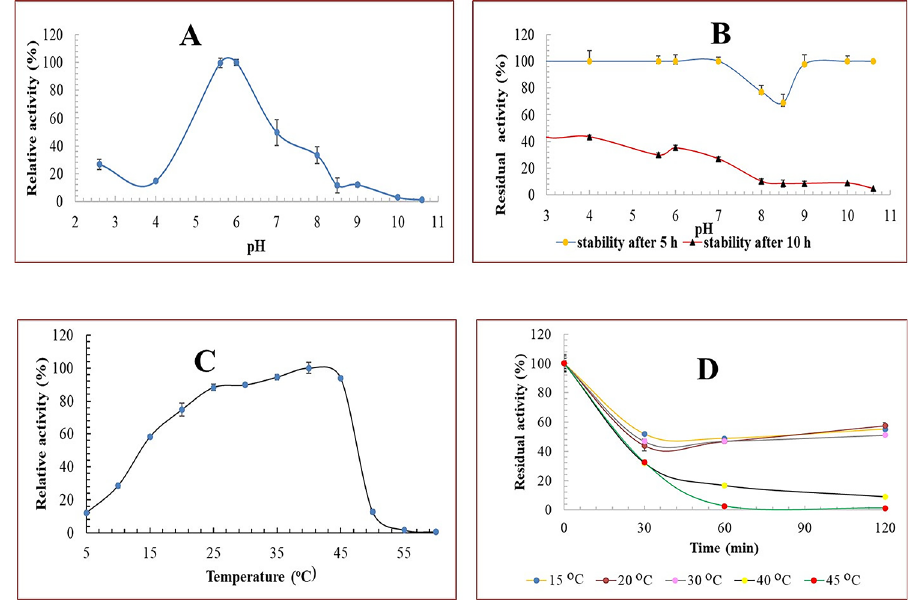
Fig. 2 pH-temperature profile of purified to homogeneity Pull_Met. A) Pull_Met activity profile over pH range 2.6–10.6. B ) pH stability profile of Pull_Met over pH range 2.6–10.6. (C) Pull_Met activity profile over temperature range 5–60 °C. (D) Temperature stability profile of Pull_Met over temperature range 15–45 °C. Results are the mean of experimental readings performed in triplicate ± SE.